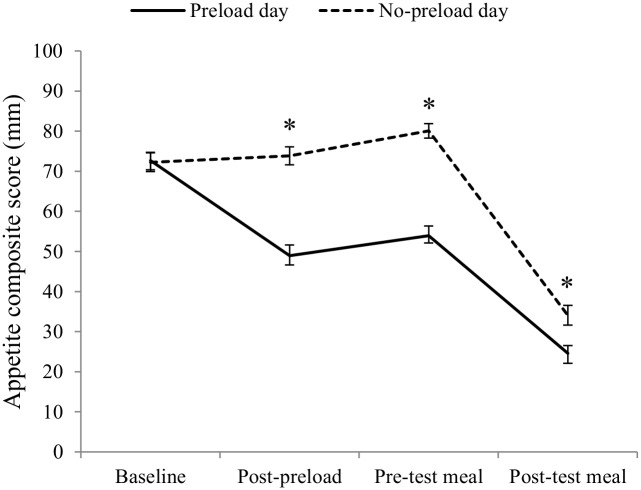
Mean appetite composite scores (100-mm VAS) on the preload and no-preload test days across measurement time points.Errors bars represent ± 1 SE from the mean. Appetite composite scores were calculated using the following formula: (hunger + (100-fullness))/2. * significant difference between preload day and no-preload day, p <.001.